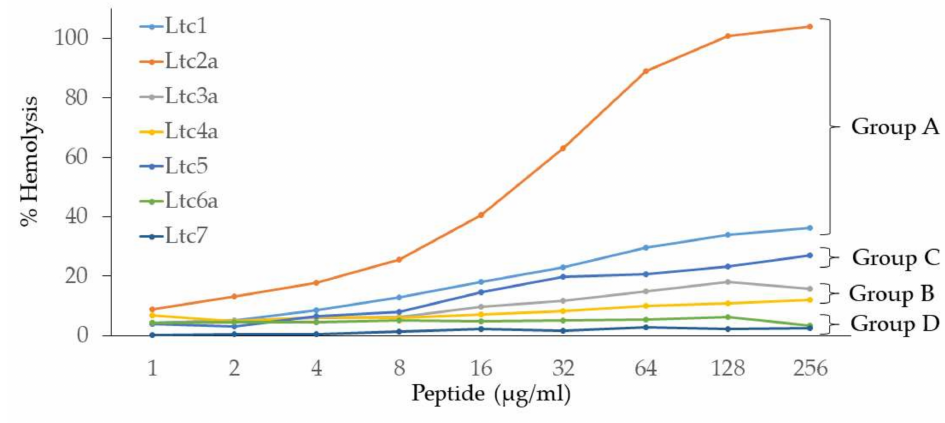
Figure 4. Hemolytic activity of latarcins as a function of the peptide